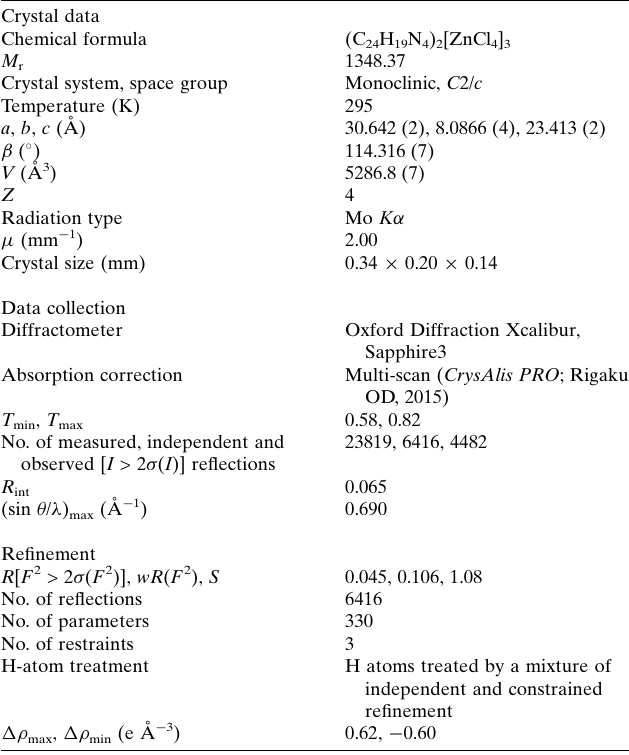
Table 7 Experimental details. Crystal data Chemical